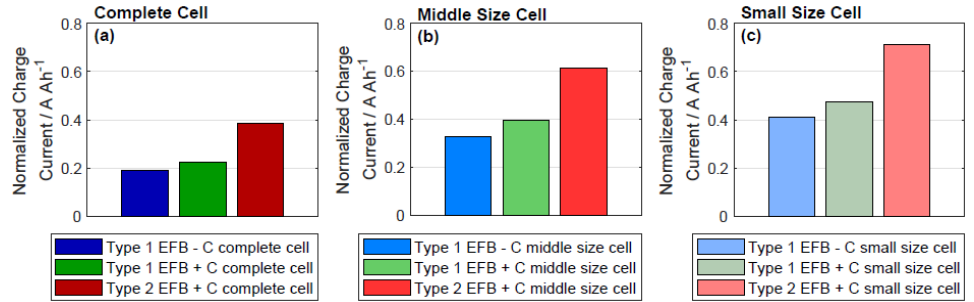
Figure 2. Normalized charge current of laboratory test cells obtained from the DCA test according to EN 50342-6:2015 for ( a ) complete cell: 8P8N/8P9N, ( b ) middle size cell: 3P2N and ( c ) small size cell: 2P1N (adapted from [16]).